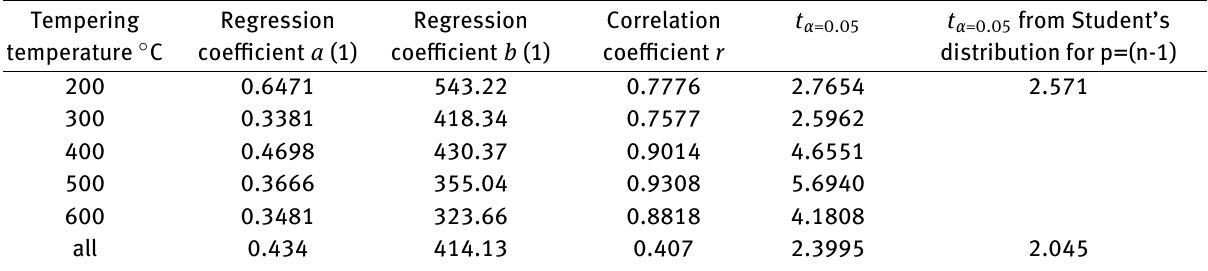
Table 2: Parameters representing mathematical models and correlation coeflcients Tempering temperature ∘